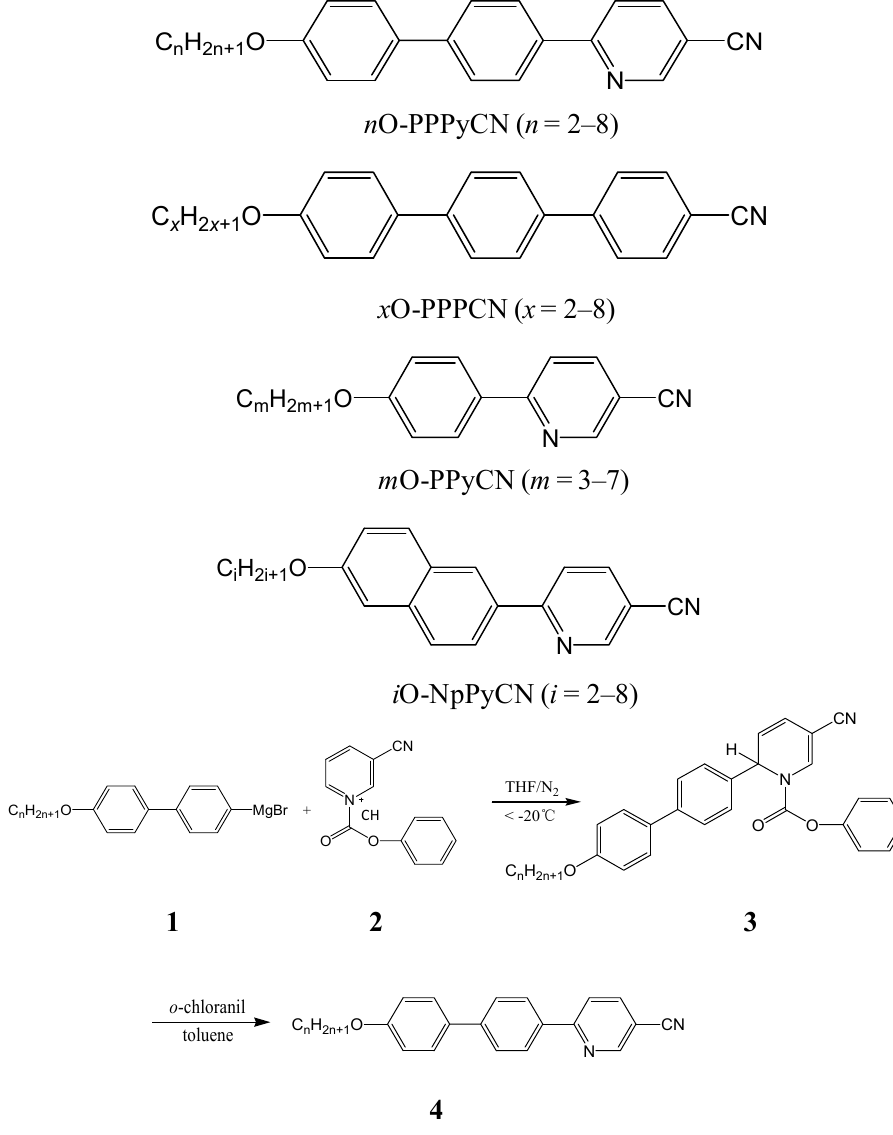
Scheme 1. Synthetic route for the synthesis of nO-